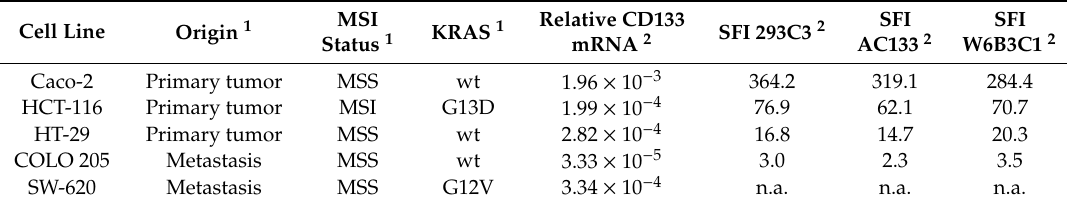
Table 1. Biological characteristics of the employed CRC cell